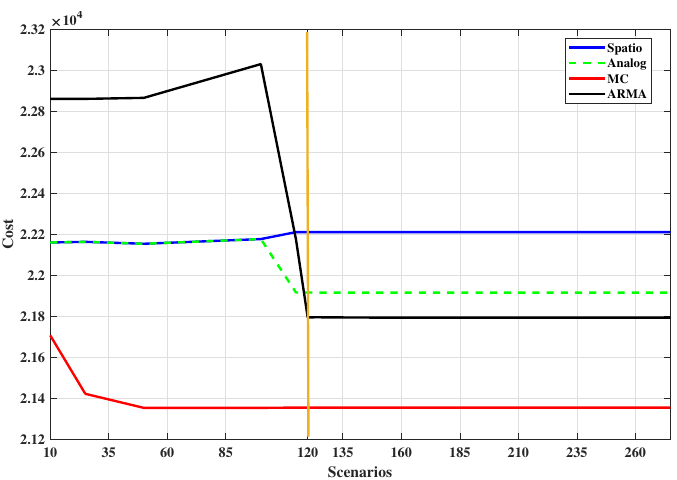
Figure 7. Changes in the objective function value vs. the number of scenarios.